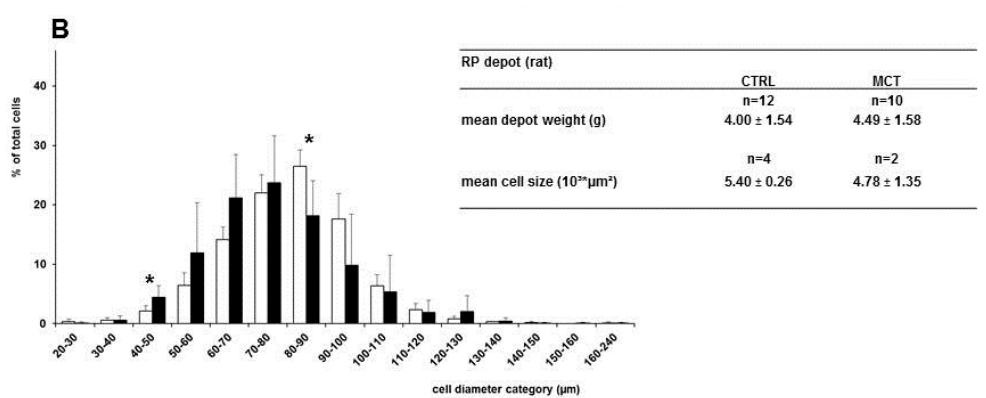
Figure 4. Panel ( A ) Frequency distribution of EPI adipocyte cell size in CTRL ( n = 8; white bars) and MCT ( n = 4; grey bars) mice on PN day 98; Panel ( B ) Frequency distribution of RP adipocyte cell size in CTRL ( n = 4; white bars) and MCT ( n = 2; black bars) rats on PN day 98. The tables show the mean depot weight and cell size. Values are means ± SD; * p < 0.05; *** p < 0.001 vs. CTRL; EPI, epididymal fat; RP, retroperitoneal fat.